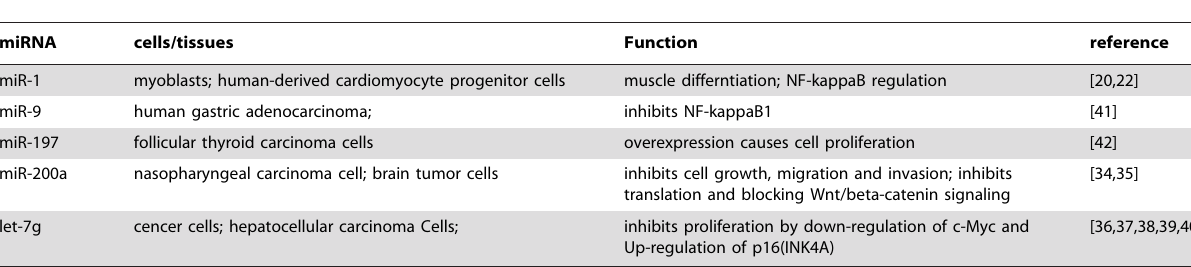
Table 3. Cell proliferation related miRNAs, which were regulated by let-7b.